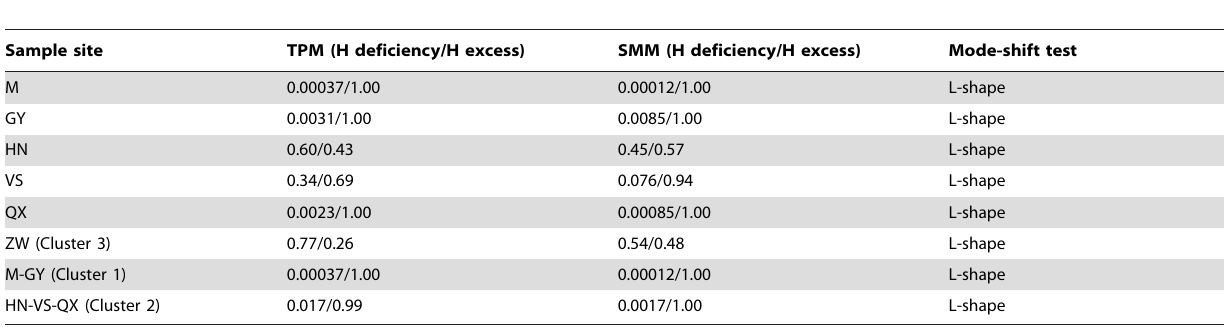
Table 4. Summary of results from BOTTLENECK for six Naja atra populations for the Wilcoxon’s test for both the two-phase model (TPM) and stepwise mutation model (SMM) along with results from the mode-shift